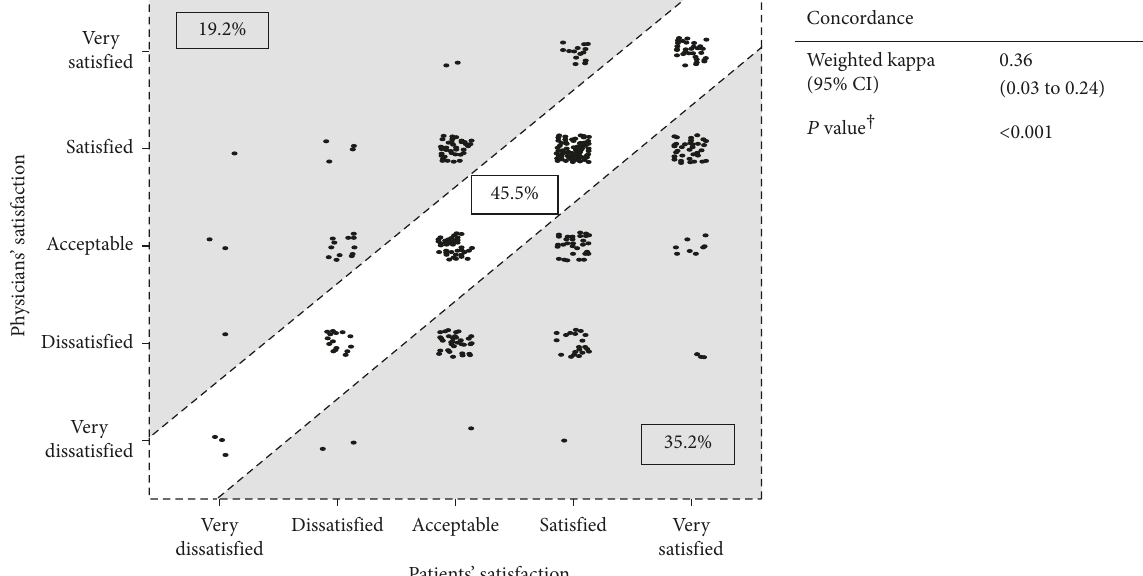
462). † McNemar’s test. CI: confidence (cid:31)